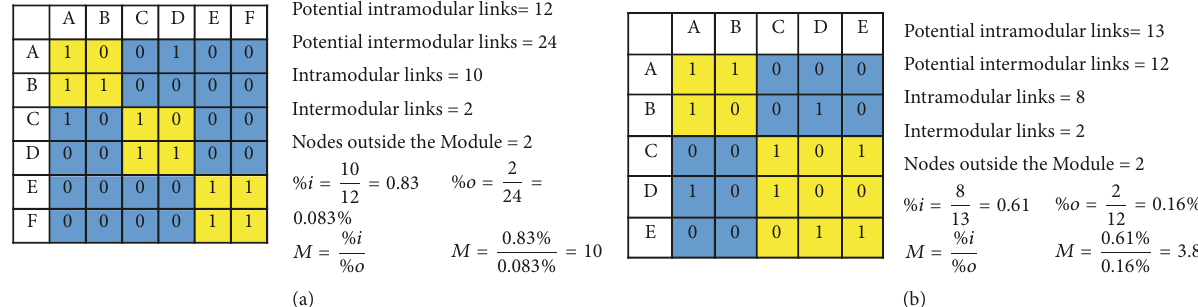
Figure 3: Examples showing how to calculate the modularity 𝑀 . Yellow boxes indicate modules. (a) Modularity with homogeneous modules. (b) Modularity with nonhomogeneous